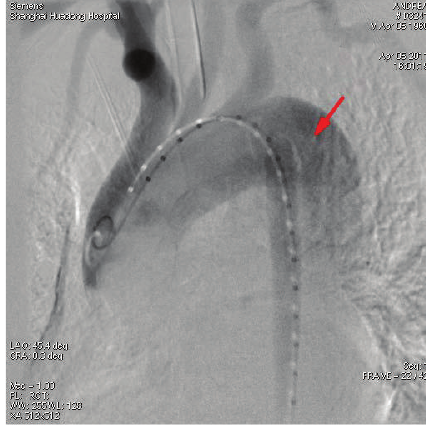
Figure 2: DSA image reveals both true and false lumens (arrow).